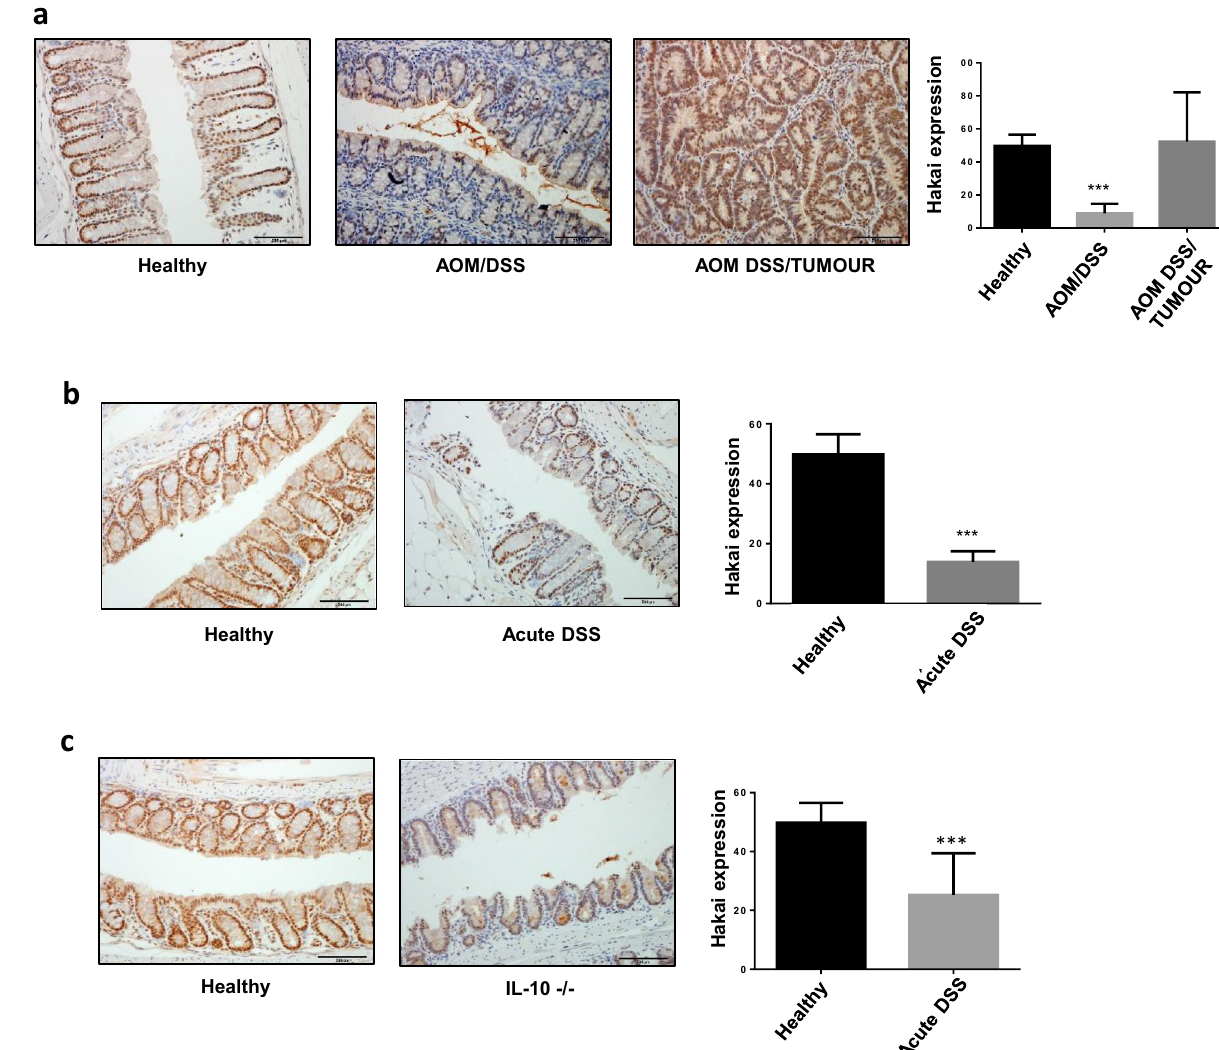
Figure 1. Expression of Hakai in mouse models of colitis and CAC. ( a ) Immunohistochemistry staining of Hakai in healthy non-treated mouse colonic mucosa and in gut sections of AOM/DSS-treated mouse (inflamed epithelium and tumours, healthy mice, n = 7; AOM/DSS-treated mice, n = 14) . ( b ) Immunohistochemistry staining of Hakai in healthy non-treated mouse colonic mucosa and in gut sections for DSS-treated mouse (inflamed epithelium, healthy mice, n = 7; DSS-treated mice, n = 3). ( c ) Immunohistochemistry staining of Hakai in healthy non-treated mouse colonic mucosa and in gut sections for IL-10 deficient mice (inflamed epithelium, healthy mice, n = 7; IL-10 deficient mice, n = 6). Images obtained with ×20 objective. Five pictures of each sample were taken and quantified. Data are represented as scatter plot. Values are means ± SEM of staining intensity signal scoring per area. Quantification and calibration of the images were performed with Immunohistochemistry Image Analysis Toolbox software for Image J. Kruskal–Wallis with Tukey correction test analyses show statistical differences in AOM/DSS-inflamed tissue respect to paired healthy samples (*p < 0.05; **p < 0,01; ***p < 0,001). Scale bar 125